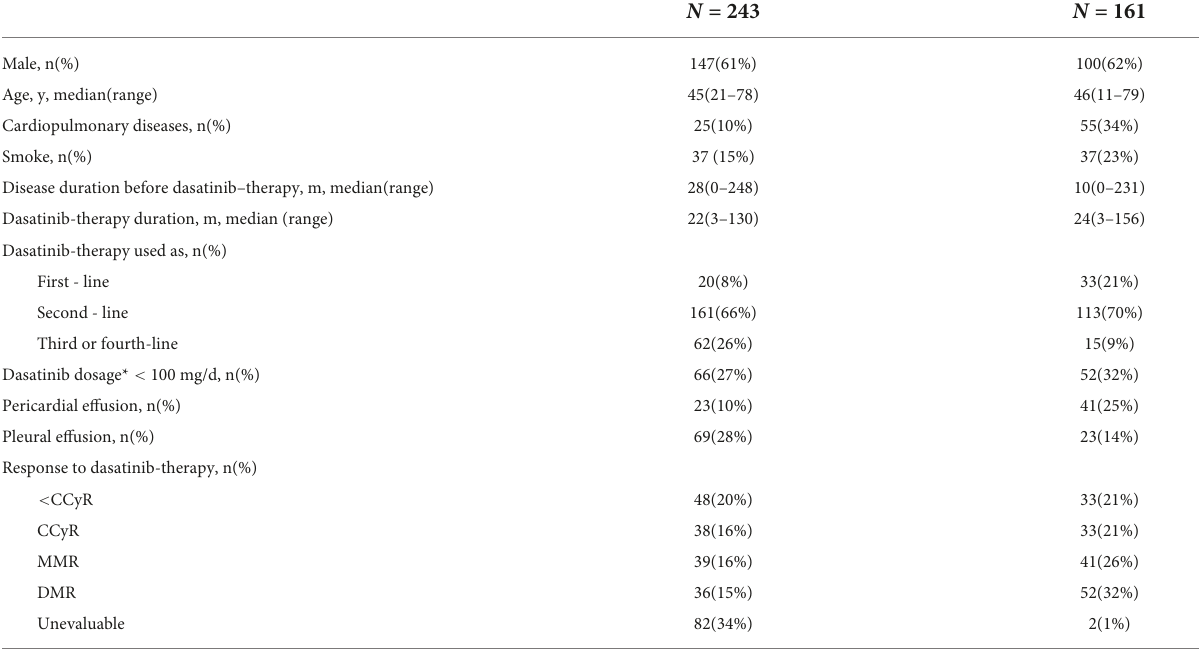
TABLE 1 Patients’